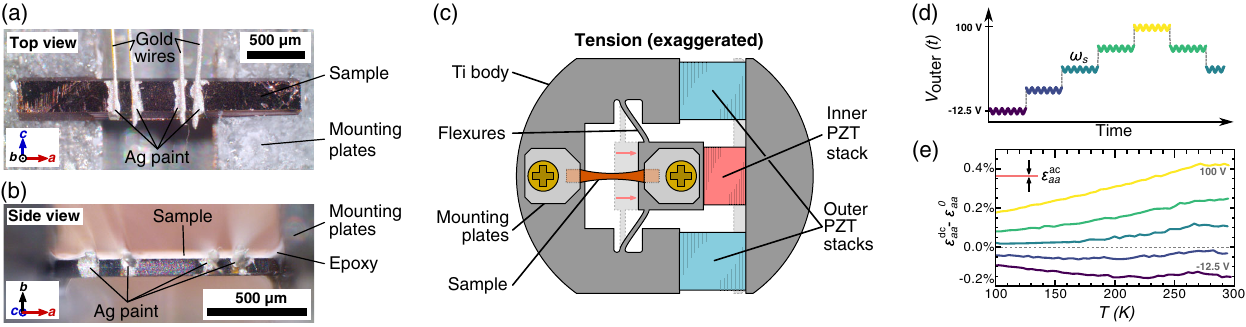
FIG. 2. Description of the experimental setup. (a) Microscope photograph of the top and (b) side of a representative ErTe 3 sample mounted in the stress cell, and contacted for a -axis resistivity and elastoresistivity measurements. (c) Illustration of the CS-100 stress cell from Razorbill Instruments. The outer two piezoelectric actuators were elongated ( V resulting in tensile stress applied to the sample. (d) Schematic of the voltage applied to the outer stacks as a function of time. The actuator voltage was the sum of a stepwise dc offset ( − 25 to þ 100 V) with a small sinusoidal oscillation (ca. 5 V continuously while the sample temperature was ramped slowly (approximately 1 K = min), and the duration of each dc step was approximately 6.5 s. (e) dc component of the strain measured for a representative ErTe 3 sample as a function of temperature and offset voltage V . The temperature-dependent response of the piezoelectric actuators contributes to some drift in strain for any given outer temperature. The height of the shaded bar in the upper left-hand corner of (e) represents the maximum amplitude of the superimposed ac strain